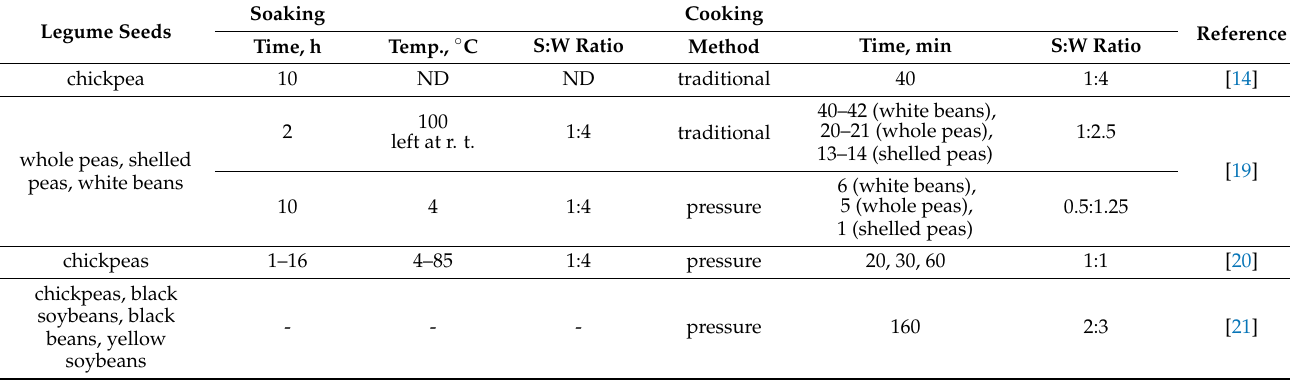
Table 1. Parameters of soaking and cooking seeds of